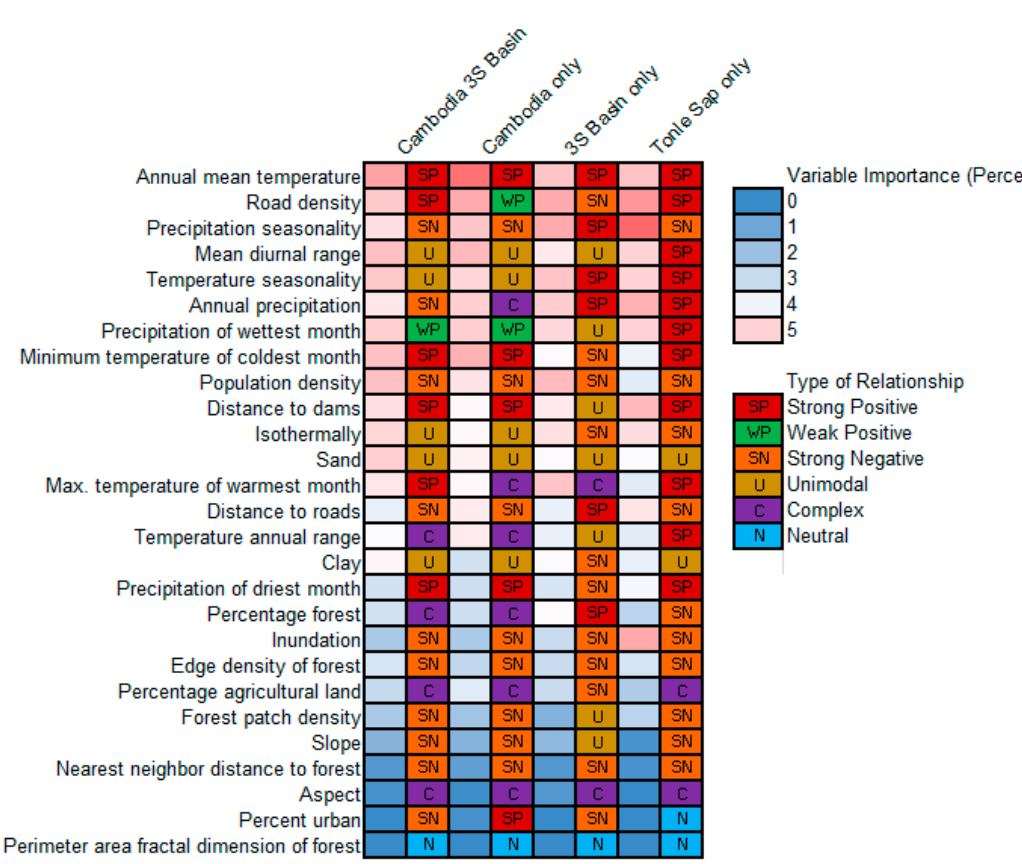
Figure 7. Variable importance calculated from mean decrease accuracy and normalized to 100%. Red colors indicate a greater variable importance and blue colors indicate a lower variable importance. The form of the relationship between variables and the response is shown using seven categories: strongly positive (SP: red), weakly positive (WP: green), strongly negative (SN: orange), unimodal (U: brown), complex (C: purple), and neutral (N: cyan). Strongly positive, weakly positive, and strongly negative relationships could be either linear or non-linear. Complex relationships typically were bimodal or multimodal.